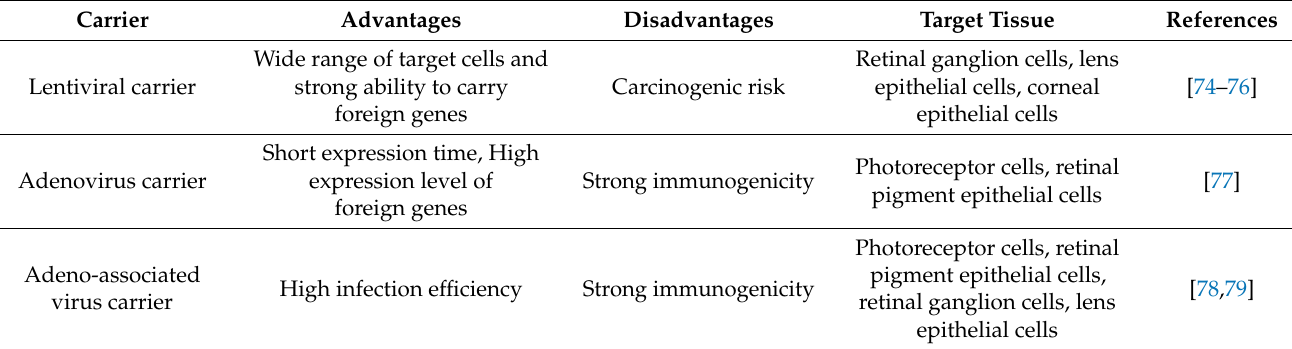
Table 3. Common viral carriers of NADs in